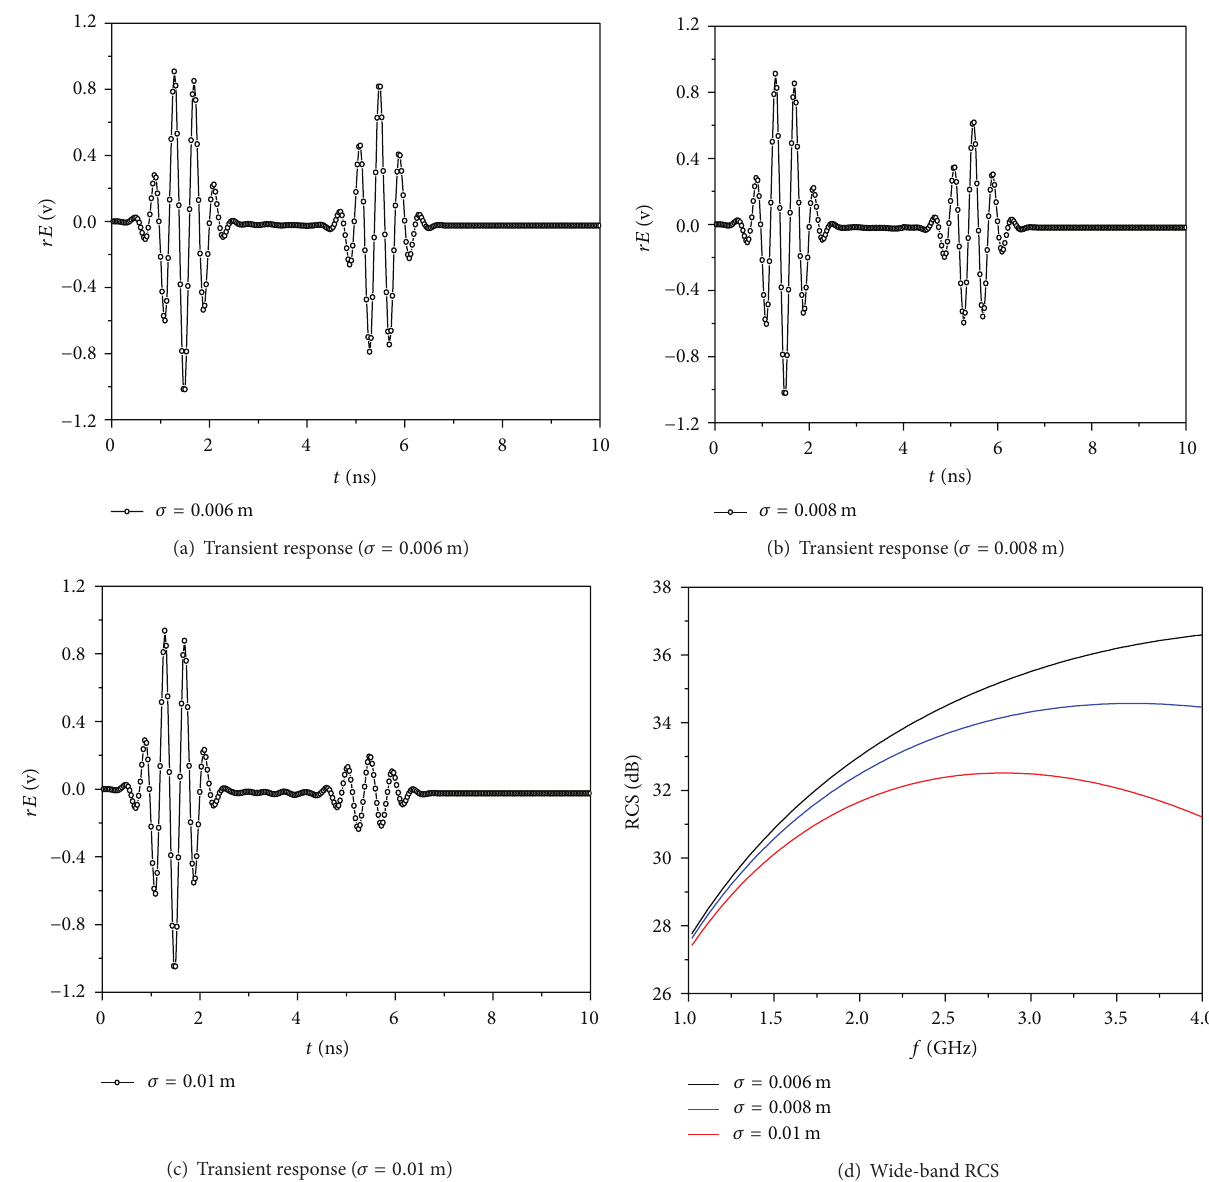
Figure 6: Scattering from the 2D PEC rough surface in the specular direction for different root square mean heights.